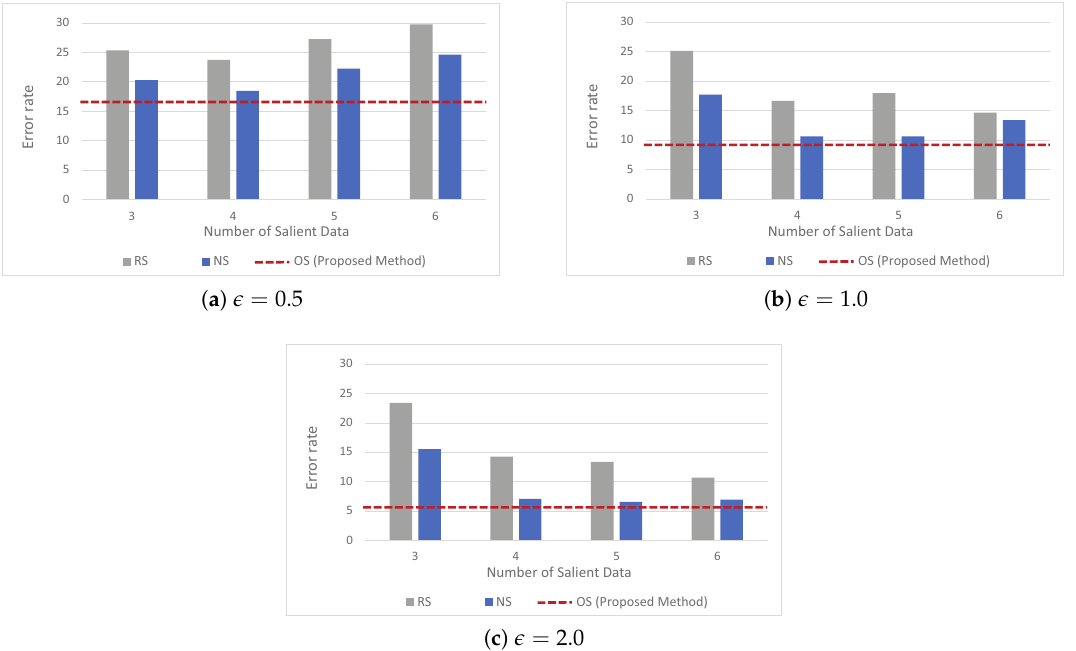
Figure 5. Average error rates for three alternative methods, RS , NS , and OS (data size = 290 × 10 2